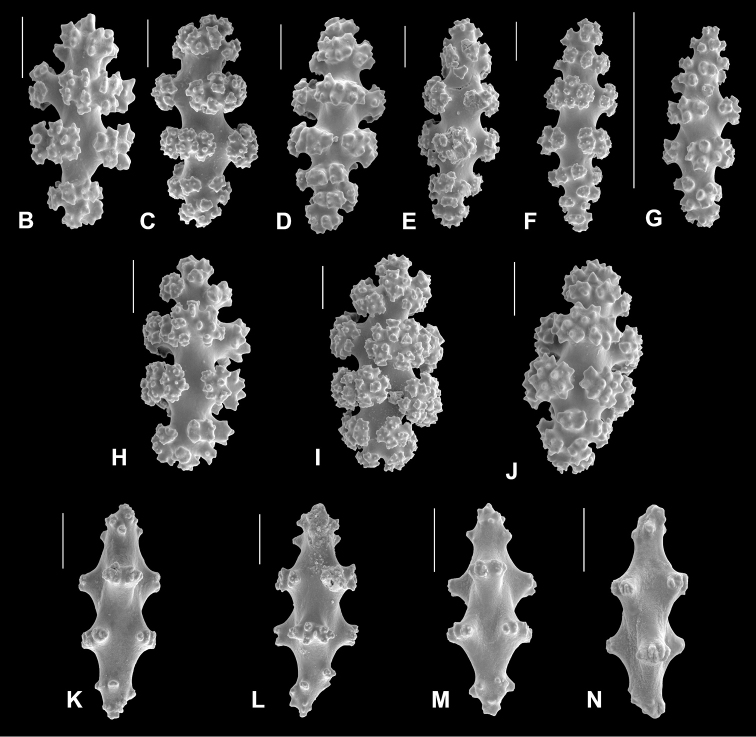
Leptogorgiafilicrispa, SBMNH 423057-Holotype. SEM image, originally published as figure 2B–N in Horvath (2011, Proceedings of the Biological Society of WA, 124: 1, page 48). Image prepared by D Geiger, SBMNH. Color of sclerites variable, from white, cream, to pale, bright or deep pink, generally measuring in the range of 55–80 µm; coenenchymal spindles, scale bar 20 µm (B–F, H–J), coenencymal sclerite, scale bar 100 µm (G); anthocodial sclerites, scale bar 20 µm (K–N).